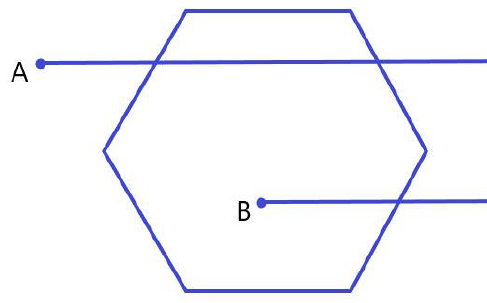
Figure 8. Cross test. Draw a ray from the point. If it is inside the border, the ray will have an odd